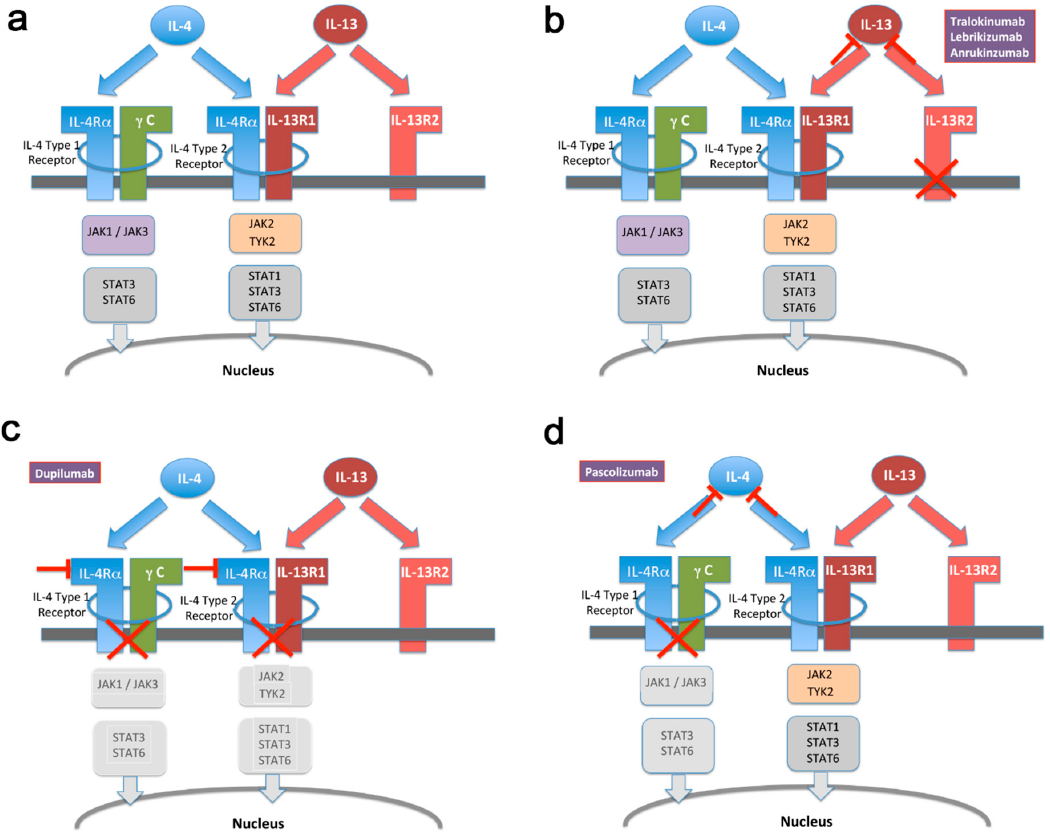
Figure 1. Schematic of IL-4 and IL-13 mediated signal transduction. ( a ) Illustration of overlapping as well as non-redundant signaling mechanisms employed by IL-4 and IL-13, respectively. For details, see text. ( b – d ) Same as in ( a ) with highlighted drugs targeting specific molecules, respectively. Drug-mediated inactivation of pathway components is illustrated by grey-shading of respective boxes. STAT = signal transducer and activator of transcription. JAK = Janus kinase. TYK = tyrosine kinase.